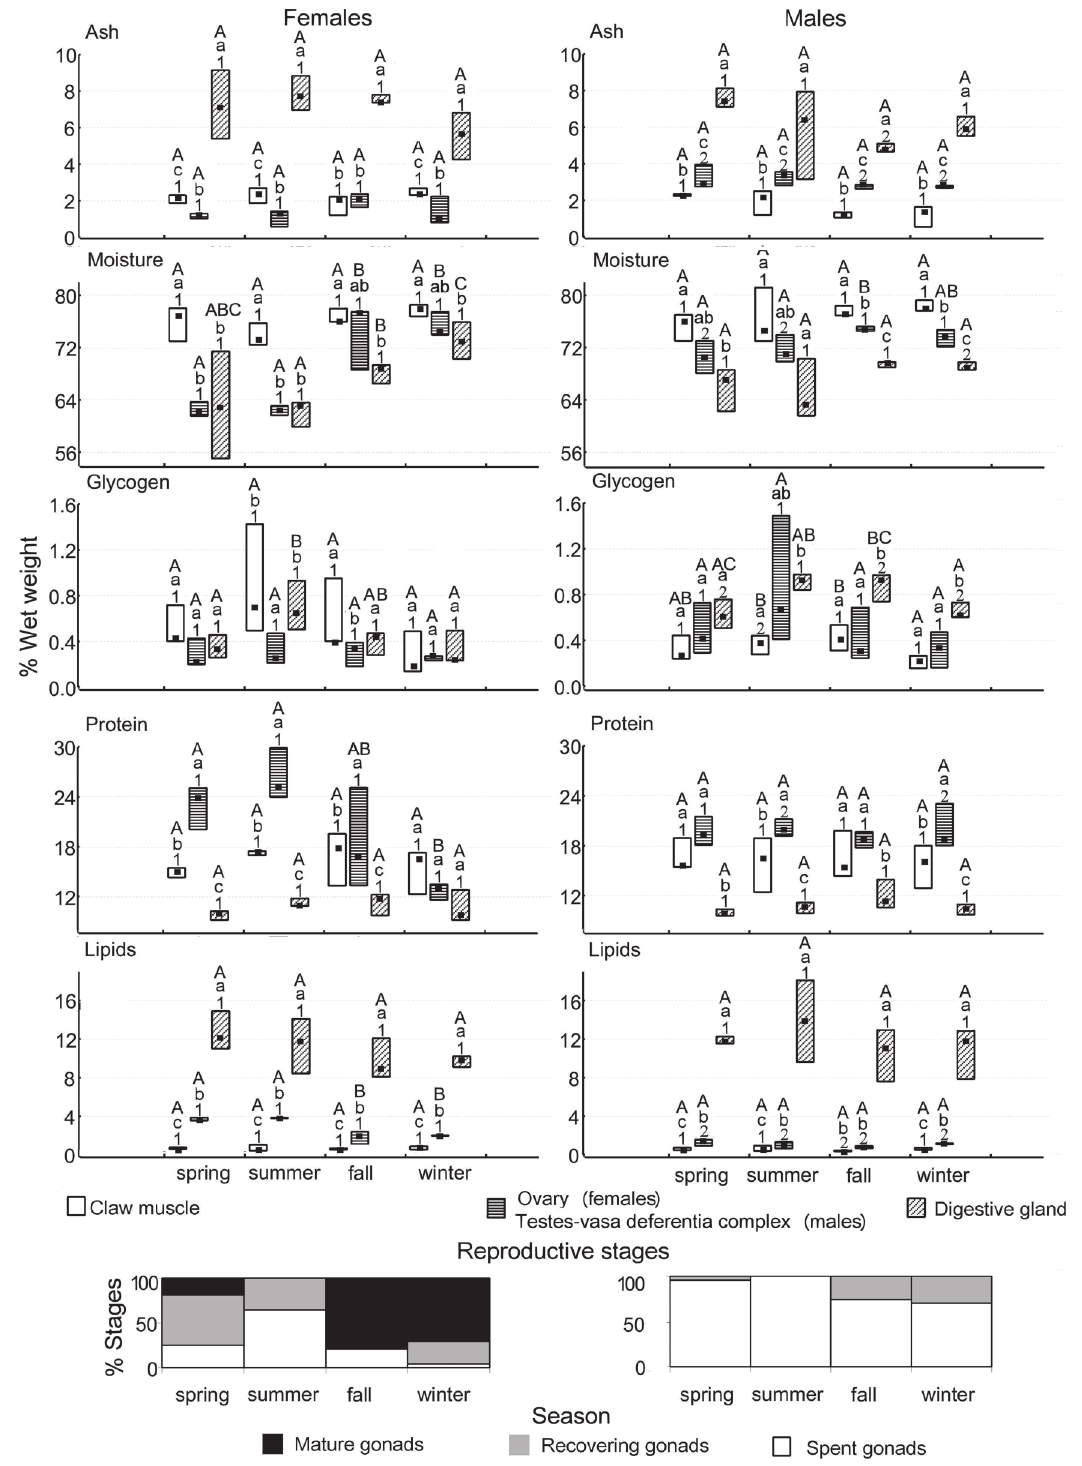
Fig . 2. – Biochemical composition (box plots) and percentage of different stages of gonadal maturity (stacked bar plots) of female (left) and male (right) Platyxanthus patagonicus in different seasons of the year. squared marks: median; box: range. Different/equal capital letters on top of the box plots represent significant/non-significant differences (Kruskal Wallis test, P<0.10 and t statistic test comparisons between pairs of treatments, P<0.05) between seasons for each combination of organ/tissue and sex; different/equal lower-case letters represent signifi- cant/non-significant differences (Kruskal Wallis test, P<0.10 and t statistic test comparisons between pairs of treatments, P<0.05) between organs/tissues for each combination of season and sex; Different/equal numbers represent significant/non-significant differences (mann and Whithney u test, P<0.05) between sexes for each combination of organ/tissue and